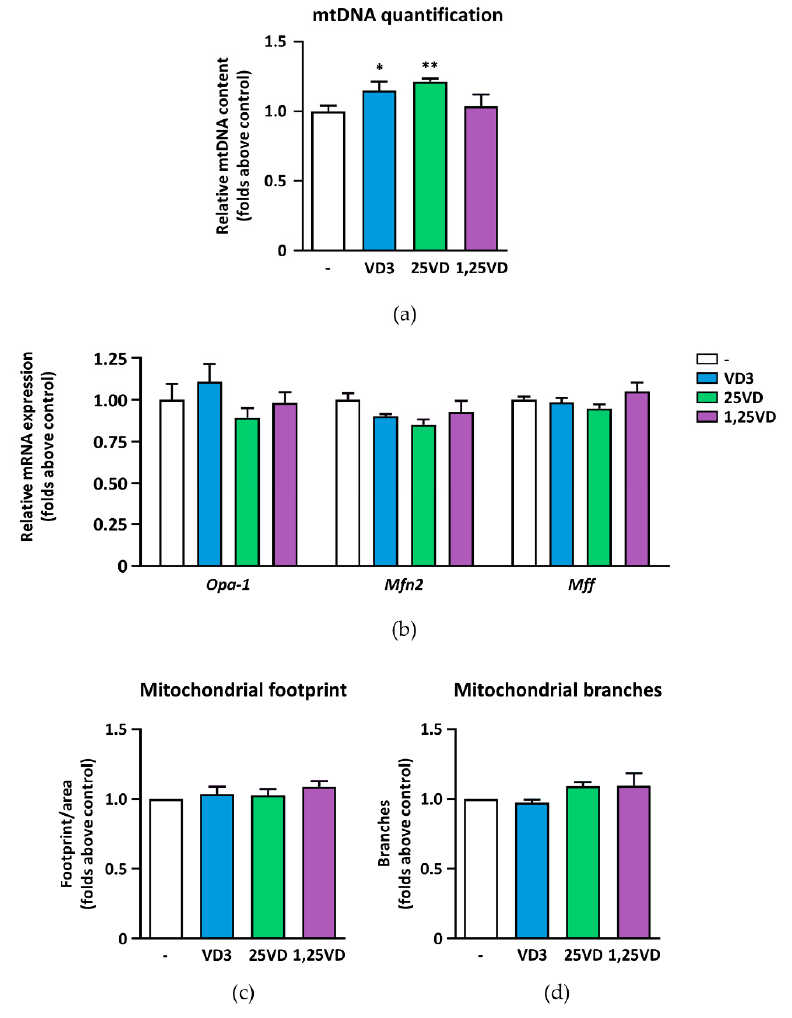
Figure 4. Effects of VD metabolites on mitochondrial content and morphology. ( a ) After treatment with 100 nM VD3, 25VD, and 1,25VD for 24 h in serum-free medium, mitochondrial DNA content in C2C12 myotubes was quantified by measuring, by real-time PCR, the expression of mitochondrial DNA gene Cox2 normalized on the genomic DNA gene Rps18 ; ( b ) the expression of fusion and fission regulator genes were assessed by real-time PCR using Gusb as the house- keeping gene; ( c ) mitochondrial footprint and ( d ) branches in MitoTracker Red-stained mitochondrial network with the MiNA plugin for ImageJ. Data are presented as means ± SEM of three independent experiments. * p < 0.05; ** p < 0.01 compared to vehicle-treated